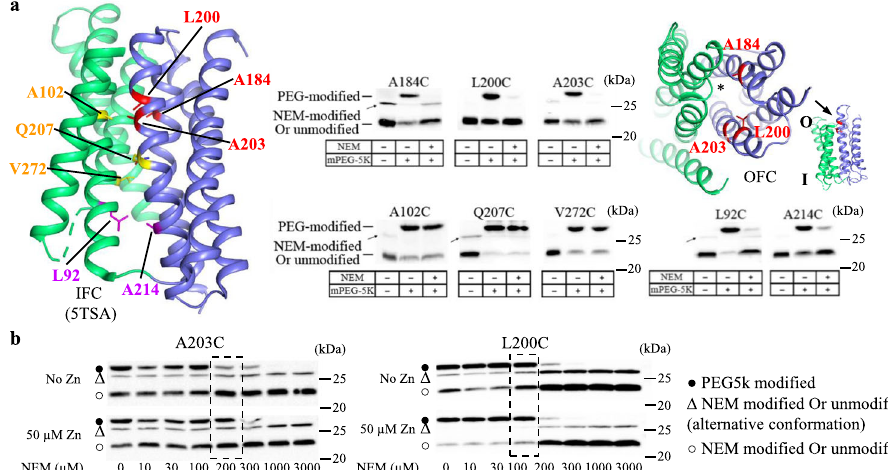
Fig.7|CysteineaccessibilityassayofBbZIPinthenativemembrane.a Cysteine accessibility assay of BbZIP single cysteine variants. The residues subjected to mutagenesistocysteinearemappedontheIFCstructure(PDBentryID:5TSA).The membranefractionofthecellsexpressingsinglecysteinevariantswastreatedwith or without NEM under native conditions, and then treated with mPEG5K under denaturingconditions.ThesampleswereappliedtoSDS-PAGEandWesternblotto detect mPEG5K-labeled (PEG-modi fi ed) and unlabeled (or NEM labeled) BbZIP. A signi fi cant reduction of mPEG5K labeling after NEM treatment indicates an access of the cysteine to NEM under native condition. The residues buried in the IFC but accessible to NEMare shownin red.The residues exposed to the solvent inthe IFC